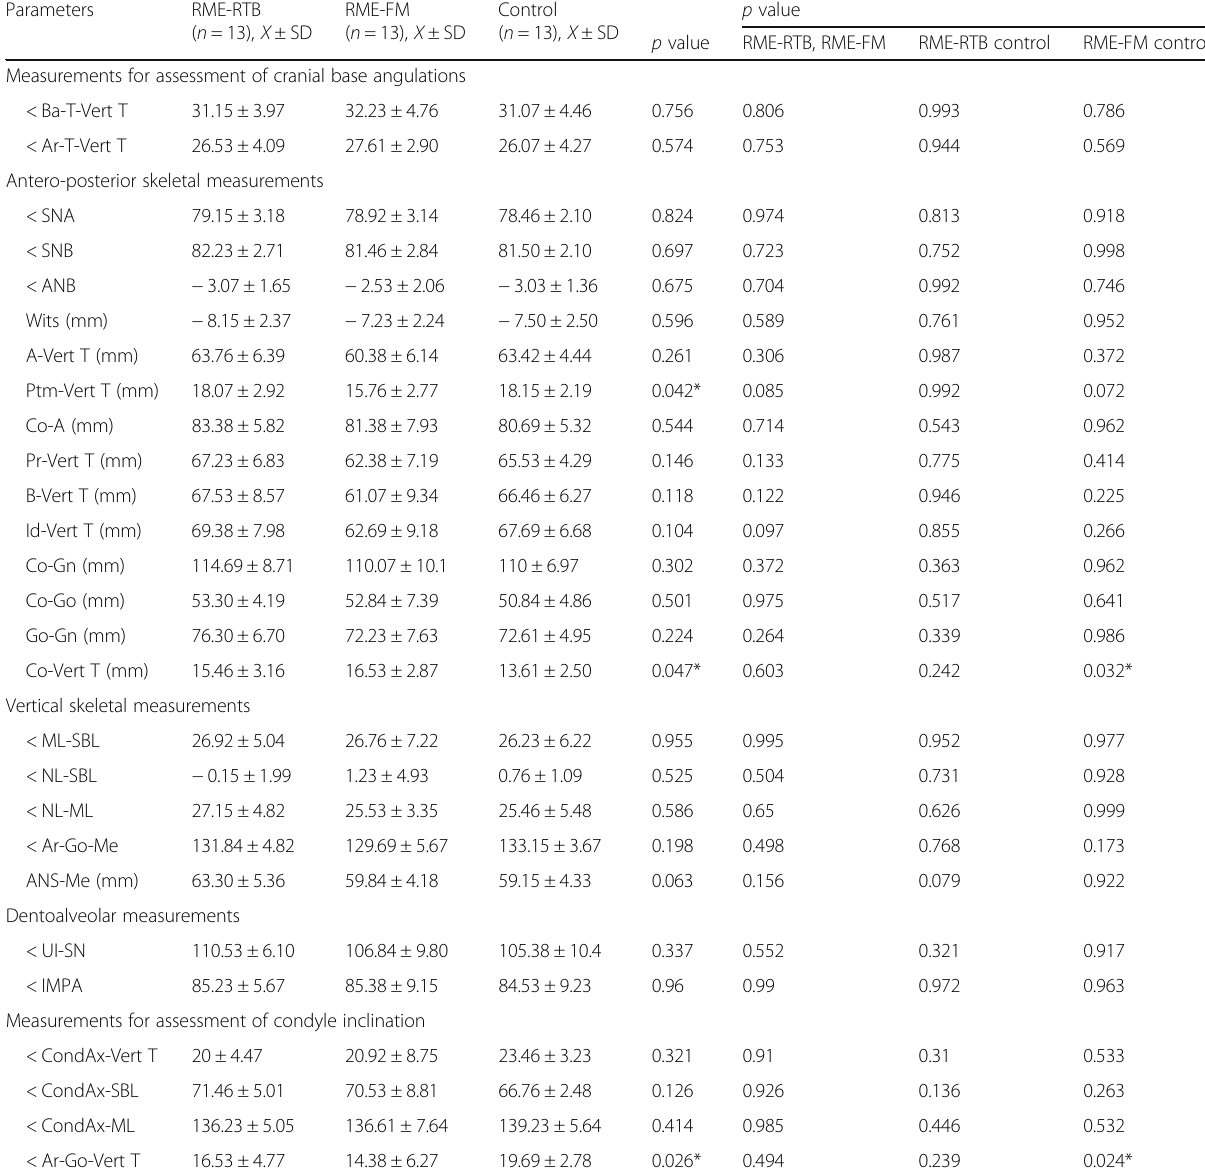
Table 3 Pre-treatment comparison (T1) of the mean values of cephalometric analysis between RME-RTB, RME-FM, and control group